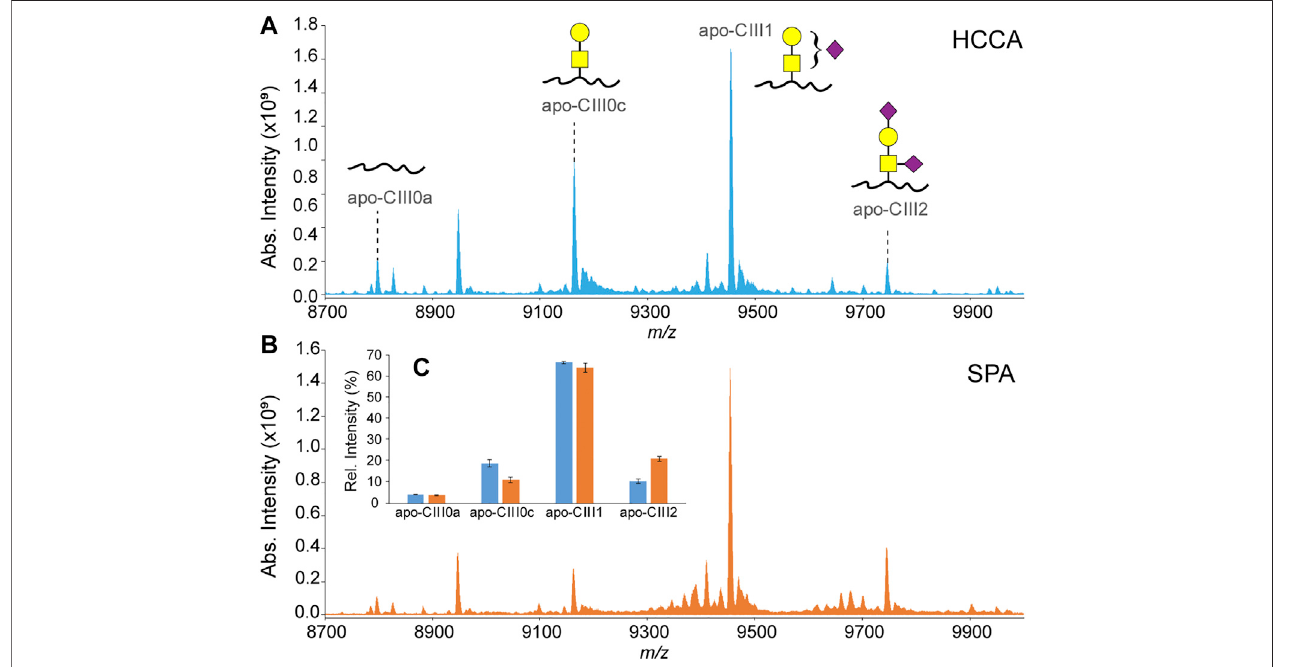
FIGURE2 | MALDI-FT-ICR massspectra ofapo-CIII proteoformsfrom H 2 O 2 -treated human blood plasmasamplesobtained using either HCCA (A) orSPA (B) as MALDI matrices. Relative peak intensities of the four most abundant proteoforms of apo-CIII are shown for both sets (n (cid:2) 3 in duplicate) of samples in the inset (C) .